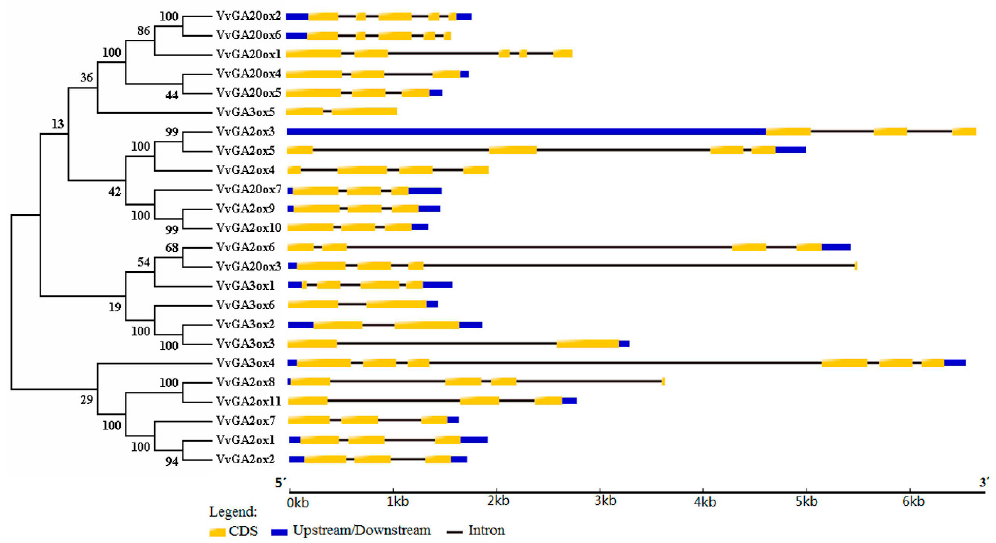
Figure 1. Phylogenetic tree and gene structure analysis of GA2ox , GA3ox , and GA20ox gene family in grape. The amino acid sequences of GA2ox, GA3ox, and GA20ox proteins were aligned with ClustalX, and a phylogenetic tree was constructed using the Neighbor-joining method (NJ) method in MEGA v.7.0. Each node was represented by a number that indicated the bootstrap value for 1000 replicates. The scale bar represented 0.1 substitution per sequence position (left). The right side illustrates the exon–intron organization of the corresponding GA2ox , GA3ox , and GA20ox genes. Exon CDS, Upstream/Downstream, and intron were denoted by the yellow boxes, blue boxes, and black lines, respectively. The scale bar represented 1 kb (right).